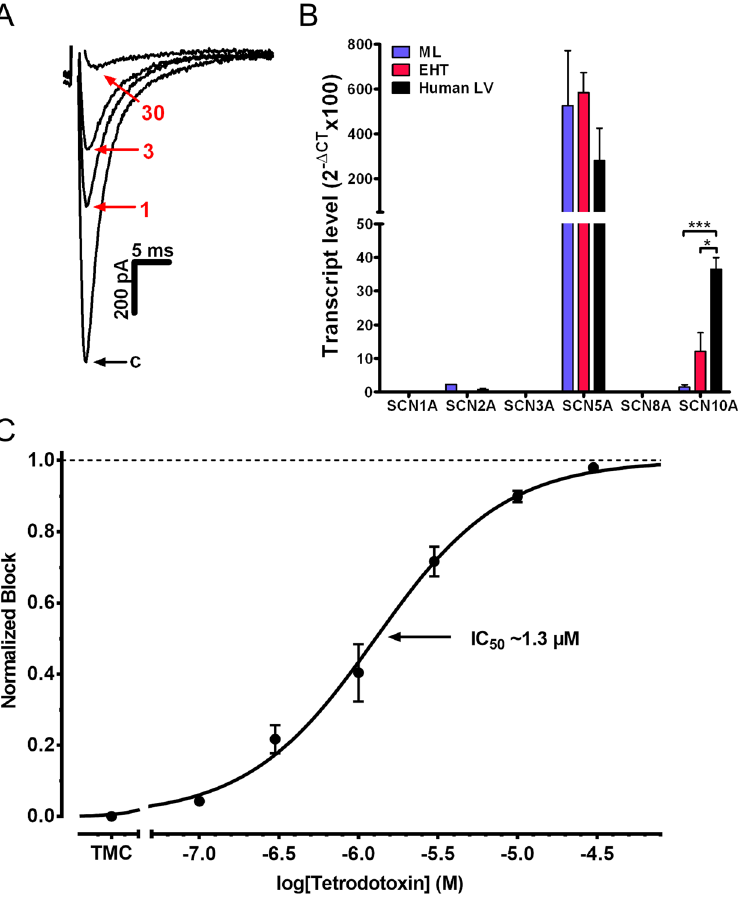
Figure 3. Concentration dependent effect of tetrodotoxin (TTX) on I Na and expression of sodium channel subunits. ( A ) Representative original Na current tracings under control conditions and after exposure to 1, 3 and 30 µ mol/L of TTX. ( B ) Transcript levels of various Na channel isoforms were quantified by qPCR in 3 samples each of human induced pluripotent stem cell-derived cardiomyocytes (hiPSC-CM) in monolayer (ML) and engineered heart tissue (EHT) format and non-failing human left ventricle (LV). SCN10A showed a different expression for ML ( *** p < 0.001 vs. LV) and EHT ( * p < 0.05 vs. LV). Sequences of primers are provided in Supplementary Table 1. CT stands for cycle threshold of PCR amplification. ( C ) Concentration- response curve for TTX on I Na in hiPSC-CM. Data are expressed as a normalized block (n = 3–9; total 30). In time-matched controls I Na remains stable over several minutes (Supplementary Figure 1). IC 50 indicates inhibitory concentration 50% of maximal